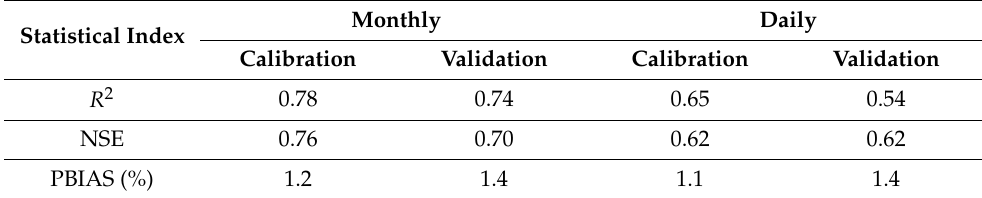
Table 5. Monthly and daily calibration and validation